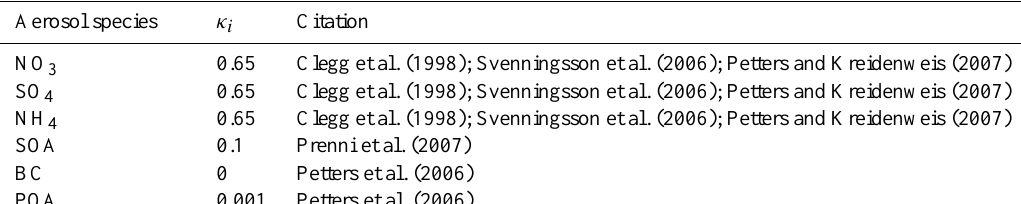
Table 3. Hygroscopicity parameter assigned to aerosol species Aerosol species κ i Citation